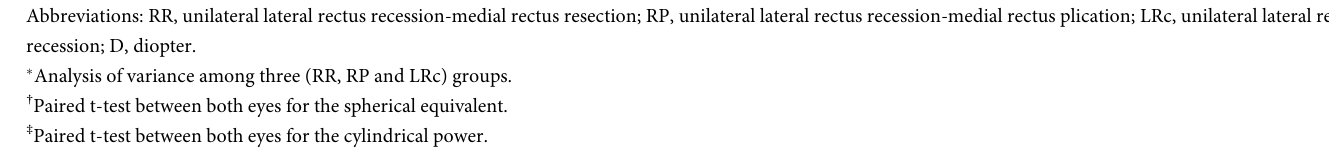
group (30.9 ± 6.0 PD at distance, and 35.9 ± 6.3 PD at near) was significantly larger than the RP group (25.8 ± 4.8 PD at distance, and 32.8 ± 4.9 PD at near), which was larger than the LRc group (21.2 ± 3.5 PD at distance, and 22.9 ± 5.3 at near). Accordingly, there was a significant difference in the amount of surgeries between the three groups. The amount of LR recession in the LRc group was 9.4 ± 0.3 mm, which was the largest among the three groups, followed by the RR group (6.3 ± 1.1 mm) and finally the RP group (5.9 ± 0.5 mm). However, there was no significant difference in stereopsis or binocular function among the groups.